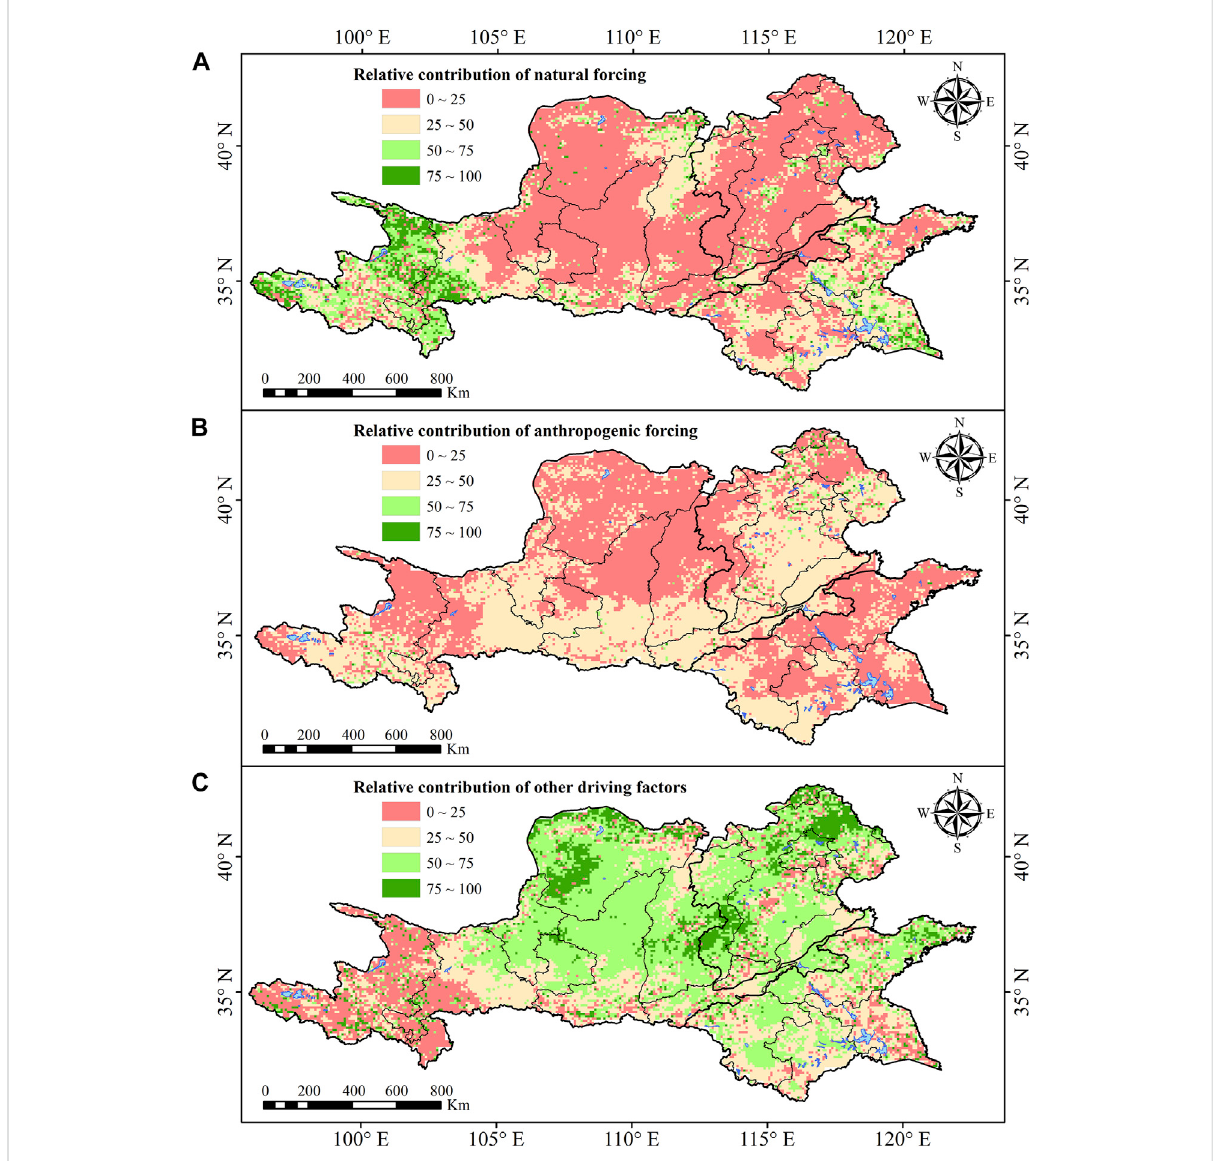
FIGURE 11 Spatial distribution of the contributions of natural forcing (A) , anthropogenic forcing (B) , and other driving factors (C) to vegetation coverage change in the YHHRB from 1982 to